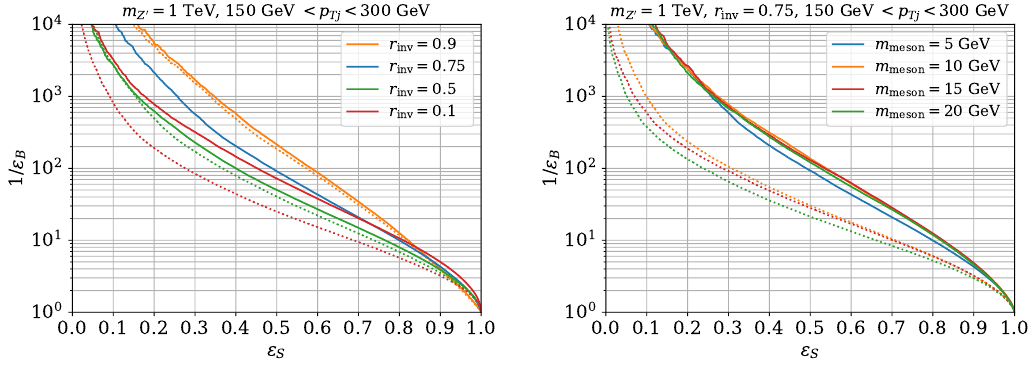
Figure 5: ROC curves (dotted lines) for the DGCNN trained on dark showers with the = 0.75 and m = Λ = 5 GeV) and tested on different benchmark values ( r inv meson d values of r (left panel) and m (right panel). ROC curves for training and inv meson testing on samples with identical parameters are shown for comparison (solid lines, as in figure